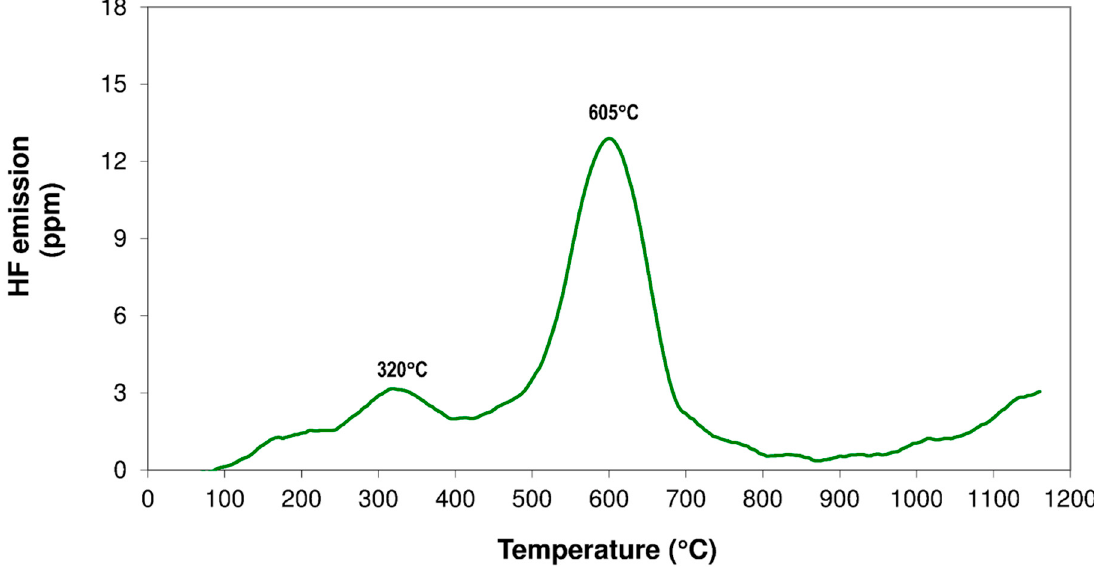
Figure 6. HF curve emission for sample BCS-CRM 348 Ball clay.